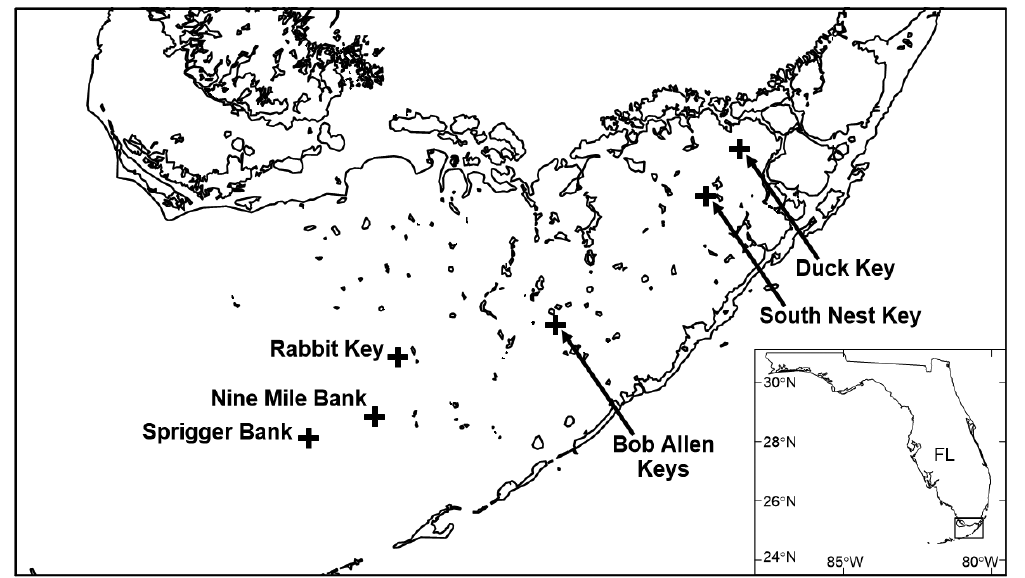
Figure 1. Map of Florida Bay and the study sites.